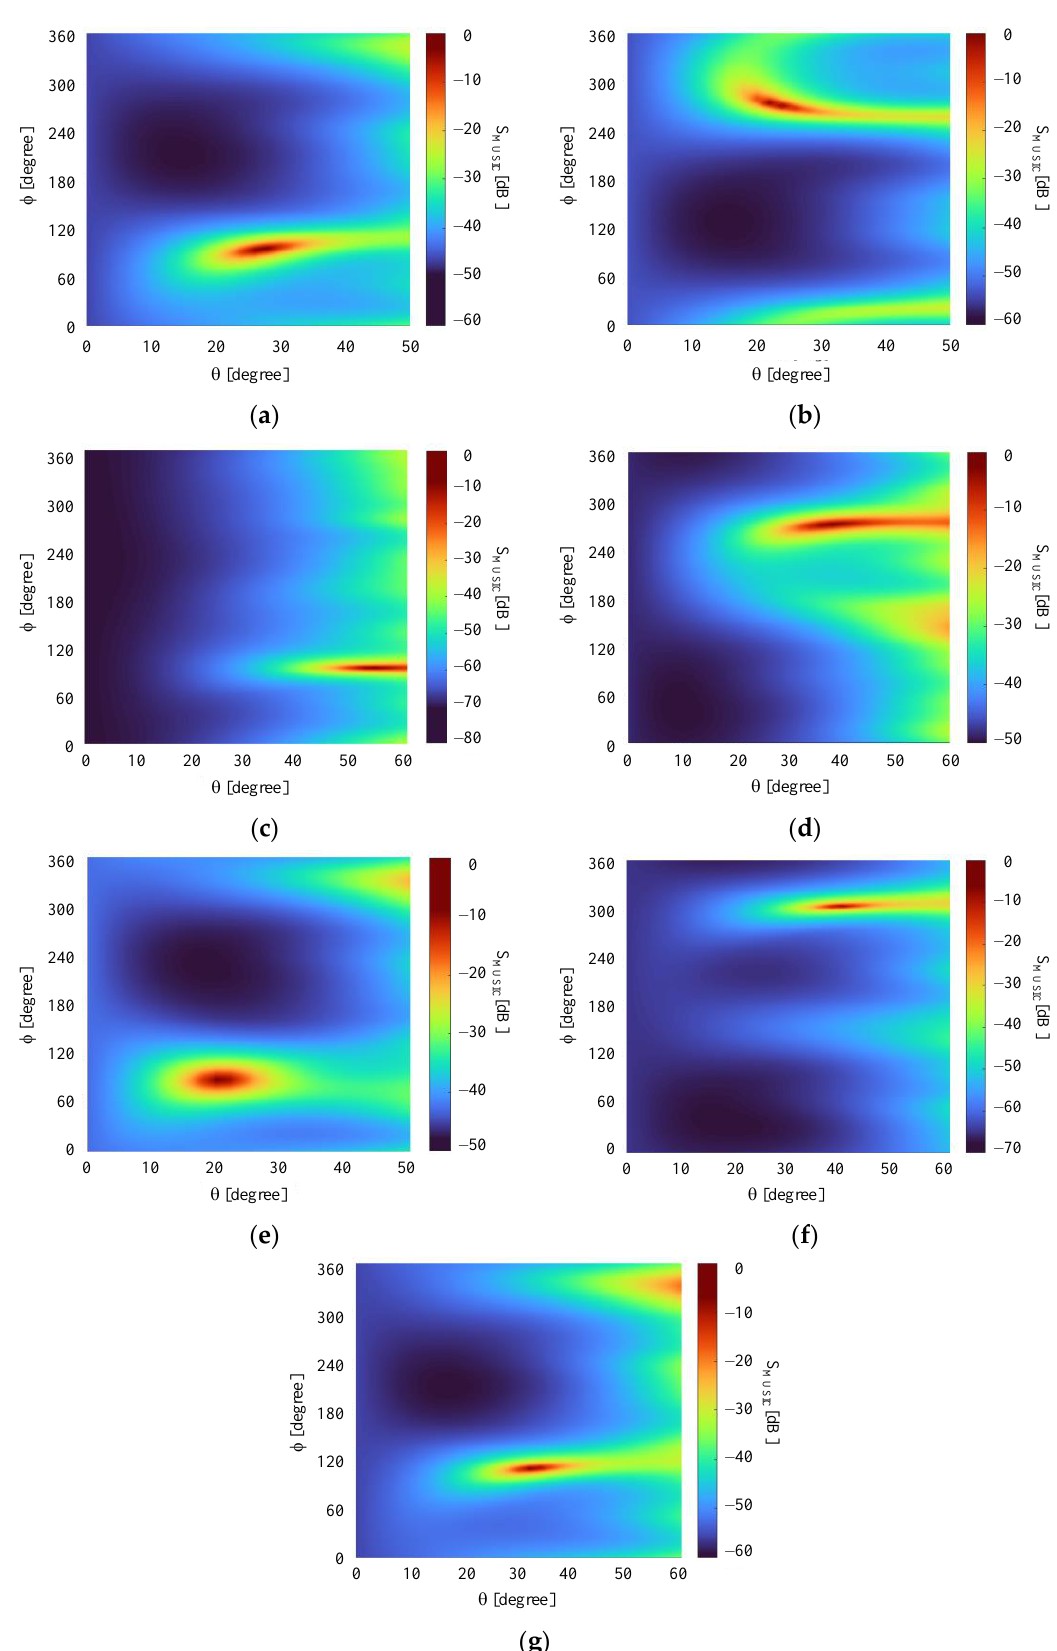
Figure 17. S MUSIC plots: ( a ) Case 1; ( b ) Case 2; ( c ) Case 3; ( d ) Case 4; ( e ) Case 5; ( f ) Case 6; ( g ) Case 7.